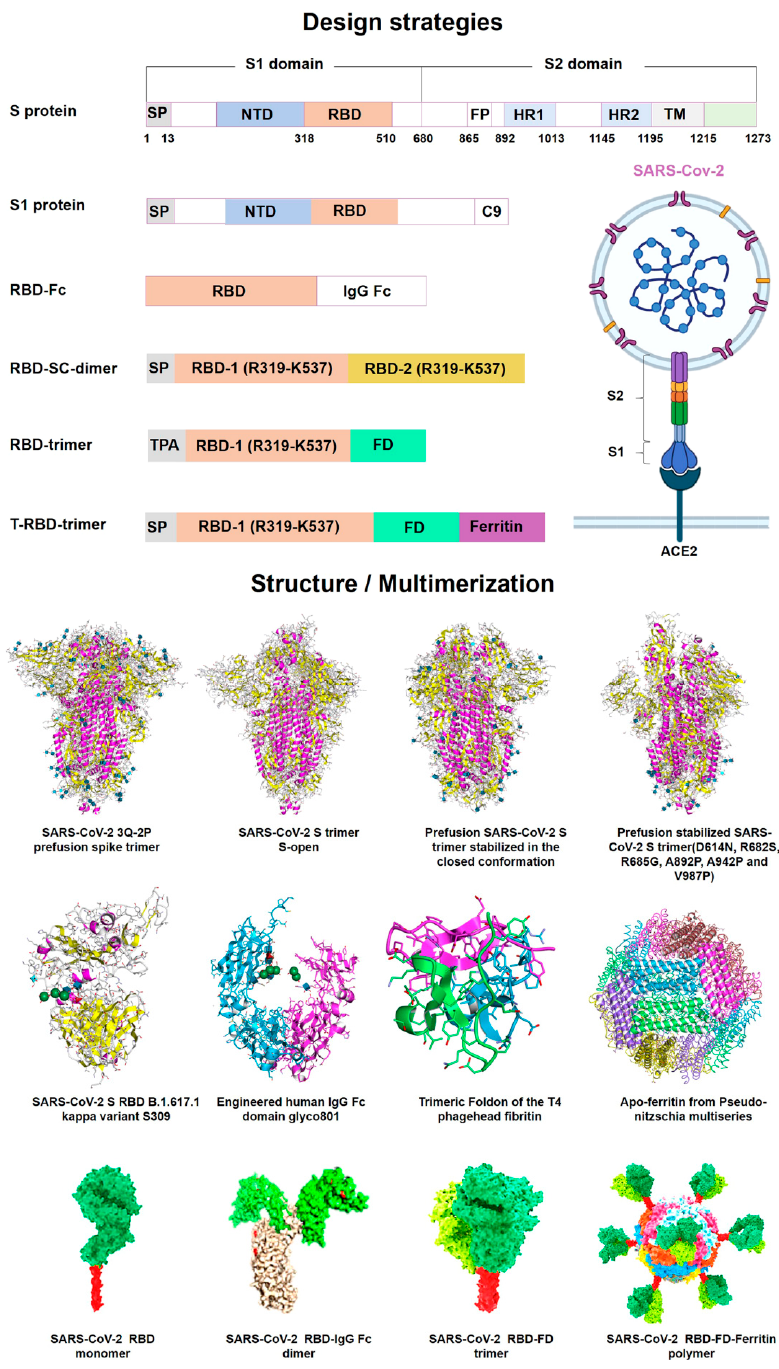
Figure 3. SARS-CoV-2 mRNA antigen immunogenicity and vaccine design. Full-length S-protein or RBD as a vaccine immunogen has been widely confirmed to induce high-affinity neutralizing antibodies. The SARS-CoV-2 S protein is intrinsically metastable and can be stabilized in a prefusion conformation by structure-based design. Prefusion-stabilized SARS-CoV-2 spike immunogen induces potent humoral and cellular immune responses. The RBD peptide is one of the most promising targets to design candidate vaccines. However, RBD has a low molecular weight, which leads to its weak immunogenicity, and can be further improved by forming multimers. Multimerization of RBD protein using humanized IgG Fc, T4 trimerization (FD), or ferritin has been shown to induce higher neutralizing antibodies compared to monomeric antigens, which will provide us with new ideas for designing powerful mRNA vaccines. (Adopted under Creative Commons Attribution 4.0 International License from